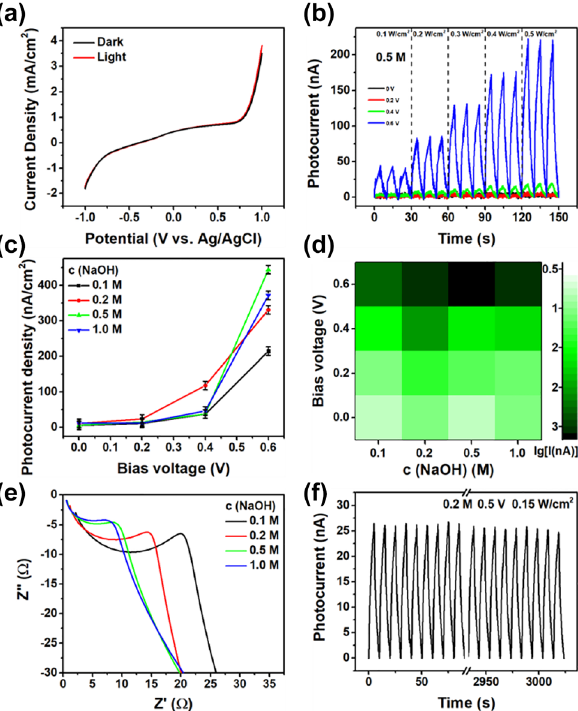
Figure 7: Photodetection performance in MXene nanosheets. (a) LSV curves of the Ti 3 C 2 detector under dark and light irradiation. (b) Photocurrent of the detectorin 0.5 MNaOH solution at a seriesof bias voltage. (c) Bias voltage dependence of photocurrentdensityin different concentration of NaOH solution. (d) Logarithm of photocurrent (lg[I]) map as a function of NaOH concentration and bias voltage. (e) Impedance spectroscopic plots of the detector in different NaOH concentration. (f) Photocurrent tests of the